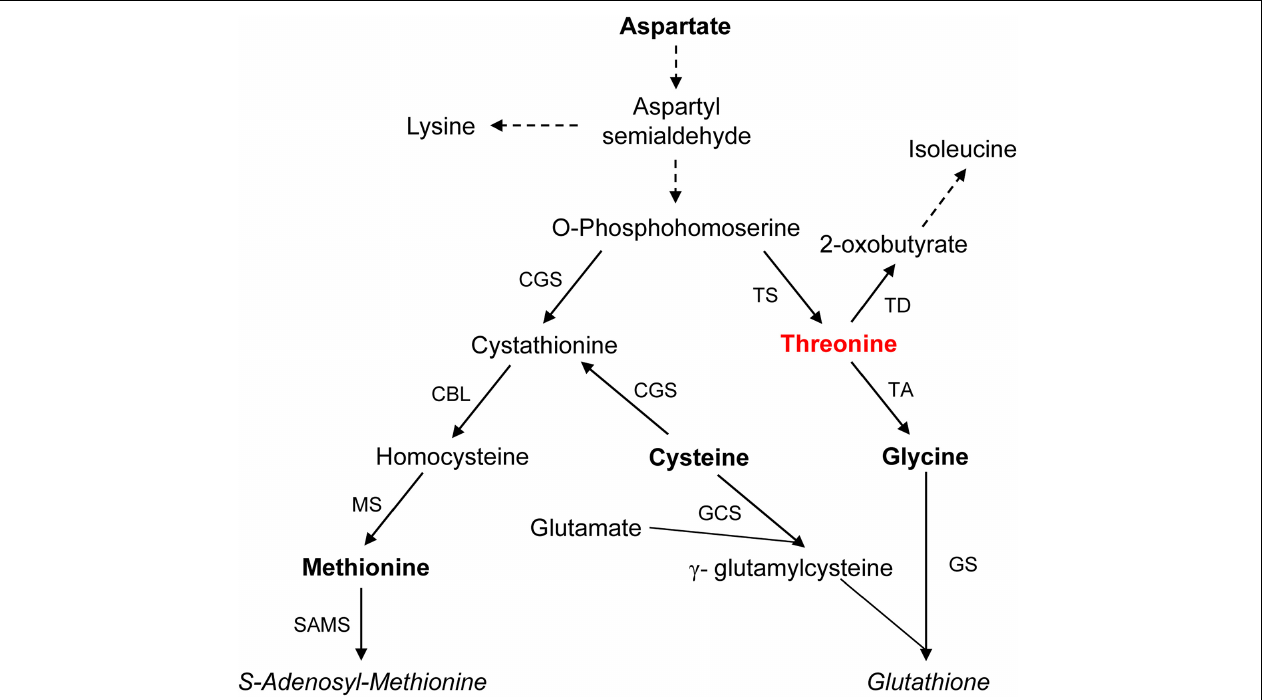
FIGURE 3 | Aspartate-derived Thr synthesis and its catabolism and related Met and glutathione synthesis in plants. Dashed lines indicate multiple enzymatic steps. Abbreviations: CBL, cystathionine β -lyase; CGS, cystathionine γ -synthase; GCS, γ -glutamylcysteine synthetase; GS, glutathione synthetase; MS, Met synthase; SAMS, S -adenosylmethionine synthase; TA, Thr aldolase; TD, Thr deaminase/dehydratase; and TS, Thr synthase. Based on Alscher (1989); Jander and Joshi (2009), and Kusano et al.